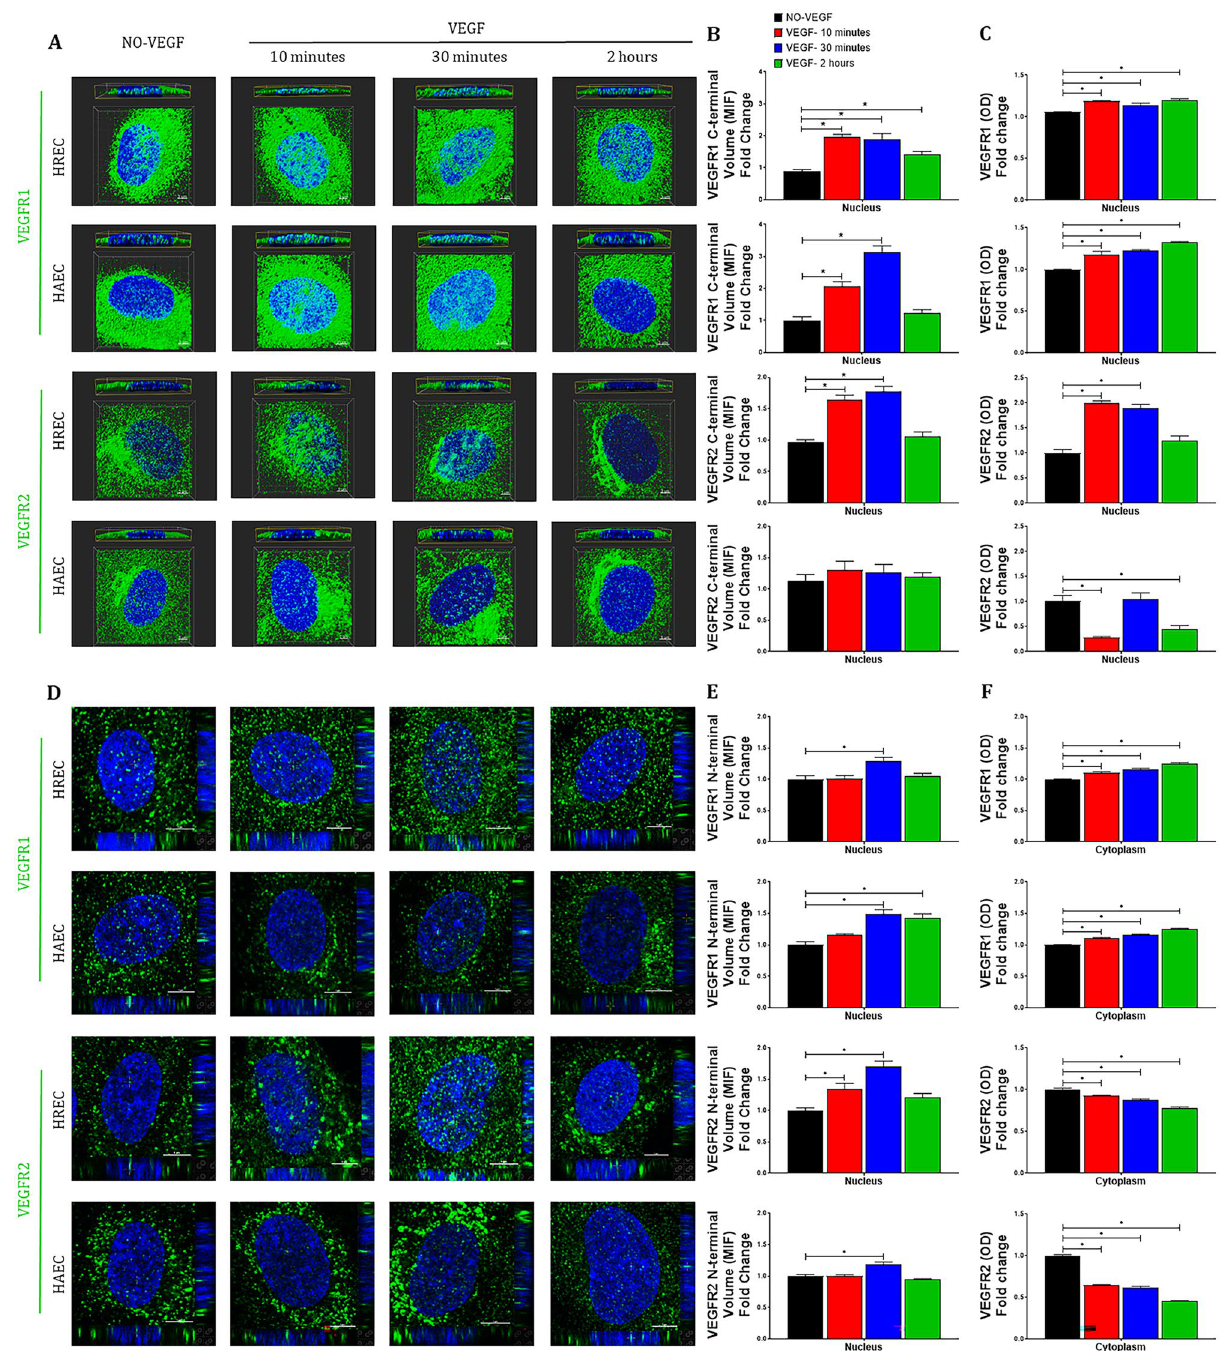
Figure 1. VEGF-induced VEGFR migration to the nucleus in micro- and macrovascular endothelial cells . The nuclear and cytoplasmic levels of VEGFR1 and VEGFR2 in HREC and HAEC were evaluated by immunofluorescence plus sandwich ELISA at different time points (10 min, 30 min and 2 h) after exposure to 100 ng/ml VEGF and compared to saline controls (NO-VEGF). Representative 3D reconstruction rendering images of the HREC and HAEC after VEGF treatment and control immunostained for ( A ) C-terminal VEGFR1 and VEGFR2. The top image of each block is the horizontal section of the 3D rendering below used as a way of showing the amount of the respective receptor inside the nucleus. Scale bars = 3 μm, and ( D ) N-terminal VEGFR1 and VEGFR2. The top left image of each block shows the position of the VEGFR1 nuclear translocation in only one focal plane and the correlation of this point are located in the 3D lateral and lower cross sections. Scale bars = 5 μm. ( B and E ) Graphs showing the quantification of the median intensity of fluorescence (MIF) volume of at least 10 confocal z-stack images at 400 × magnification for each experiment performed using NIS elements software. ( C and F ) Graphs showing the quantification of the total VEGFR1 and VEGFR2 present in nuclear and cytoplasmic fractions of the HREC and HAEC after VEGF treatment and control quantified by sandwich ELISA. All graphs represent VEGF time point fold change with respect to control NO-VEGF and the graphs bars represents the average of the a minimum of 3 separate experiments from 3 donors of the HREC and 2 donors of the HAEC. * = p < 0.05 as determined by 1-way ANOVA and multi-comparison post-hoc Tukey’s test was considered